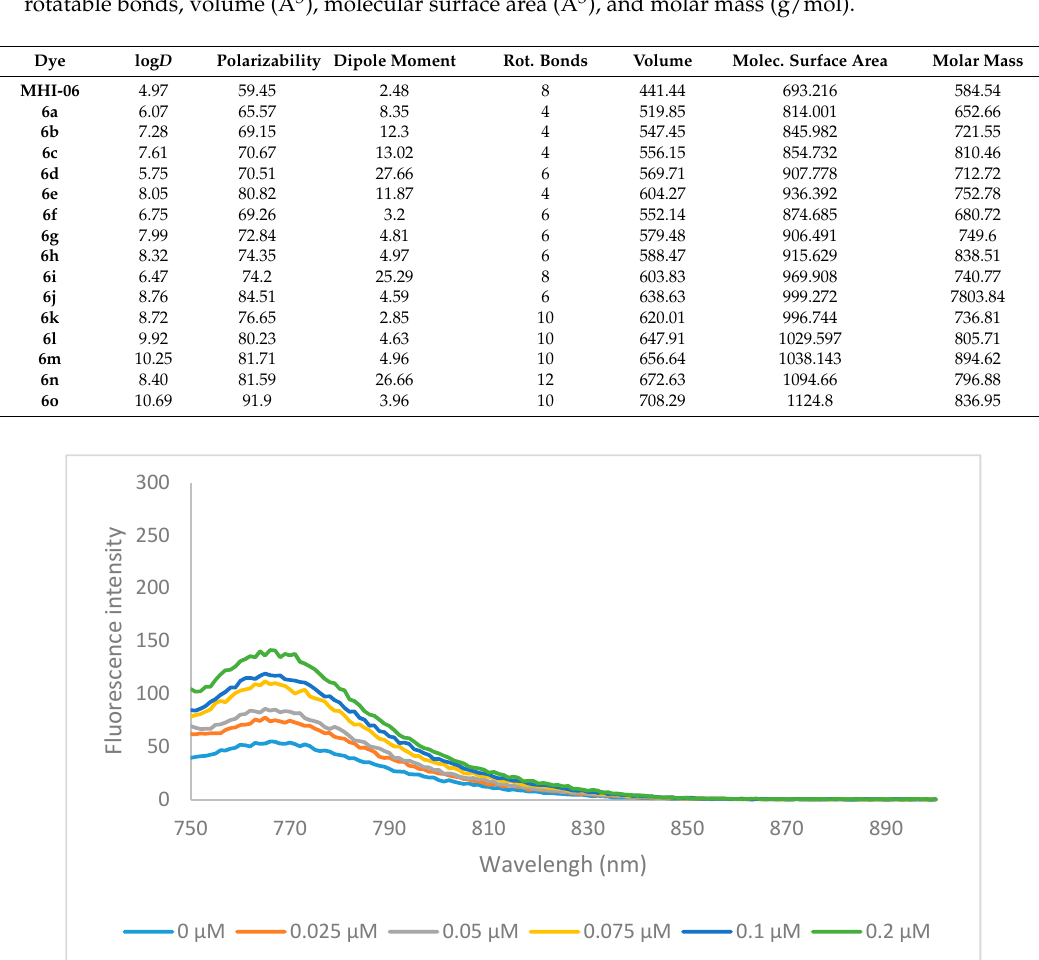
Table 2. Physicochemical properties ( in silico ) of dyes MHI-06 and 6a – o calculated using ChemAxon. The data calculated (at pH 7.4) include: logD, polarizability, dipole moment (debye), number of rotatable bonds, volume (Å 3 ), molecular surface area (Å 3 ), and molar mass (g/mol).